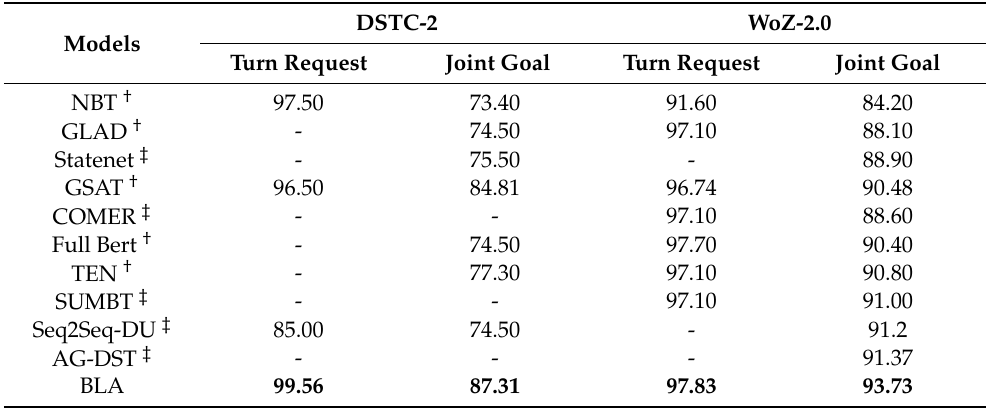
Table 4. Joint Goal Accuracy and Turn Request Accuracy on DSTC-2 and WoZ-2.0. † is used for reproduced results from official codes. ‡ is used for the reported results in respective